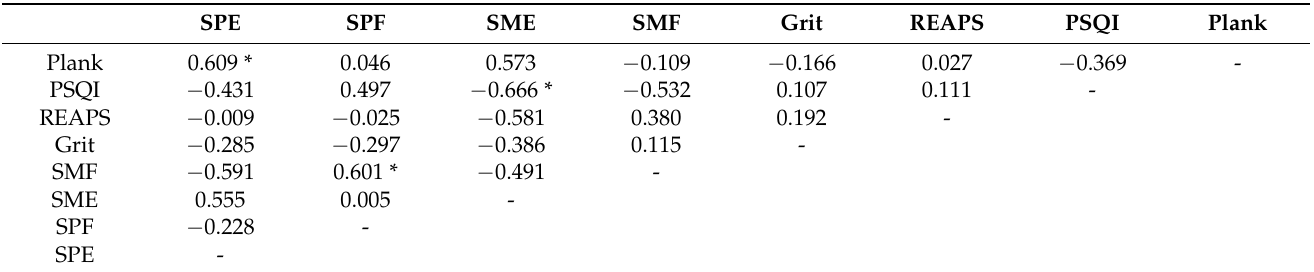
Table 4. Correlation Matrix—Mood